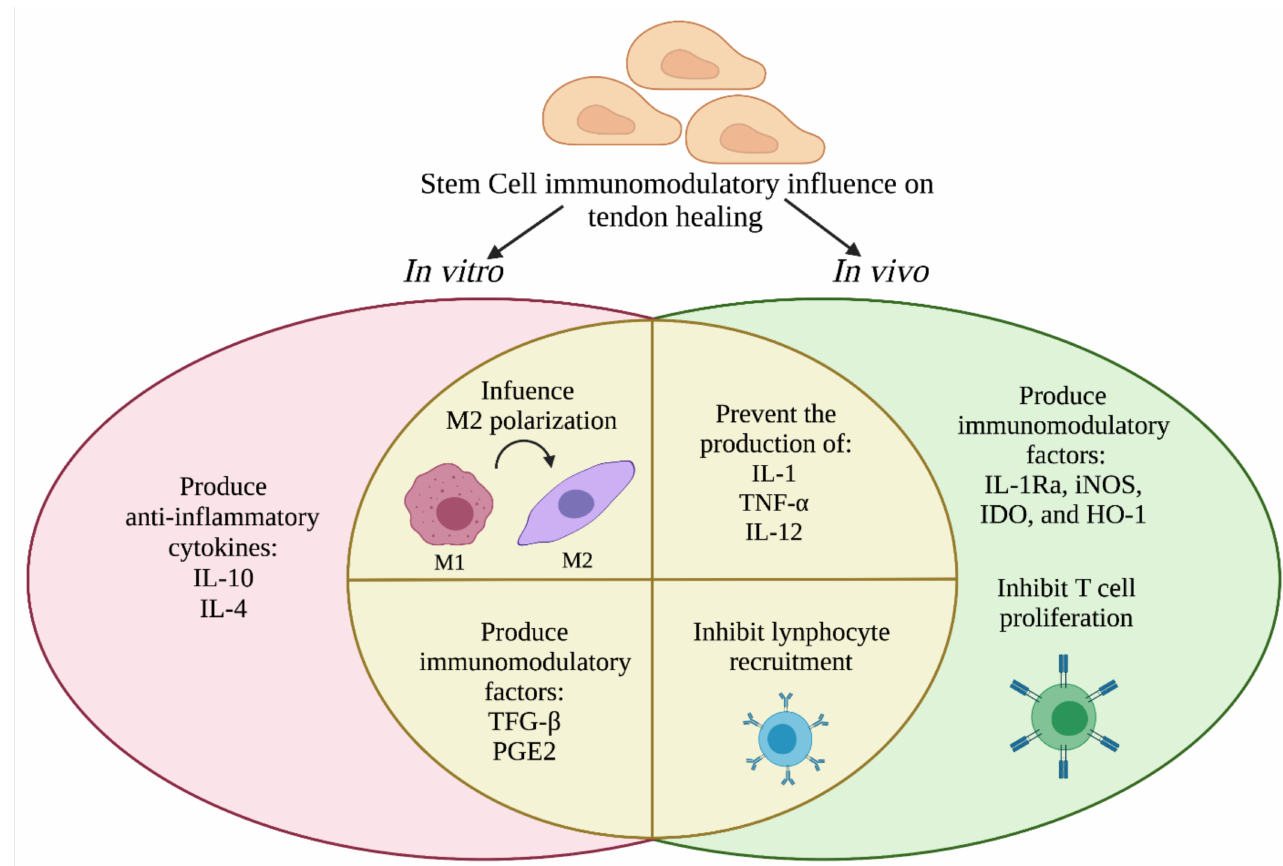
Figure 4. Schematic representation of the prevalent immunomodulatory activities of stem cells during tendon healing tested in vitro and in vivo. The image was adapted from Plock et al.